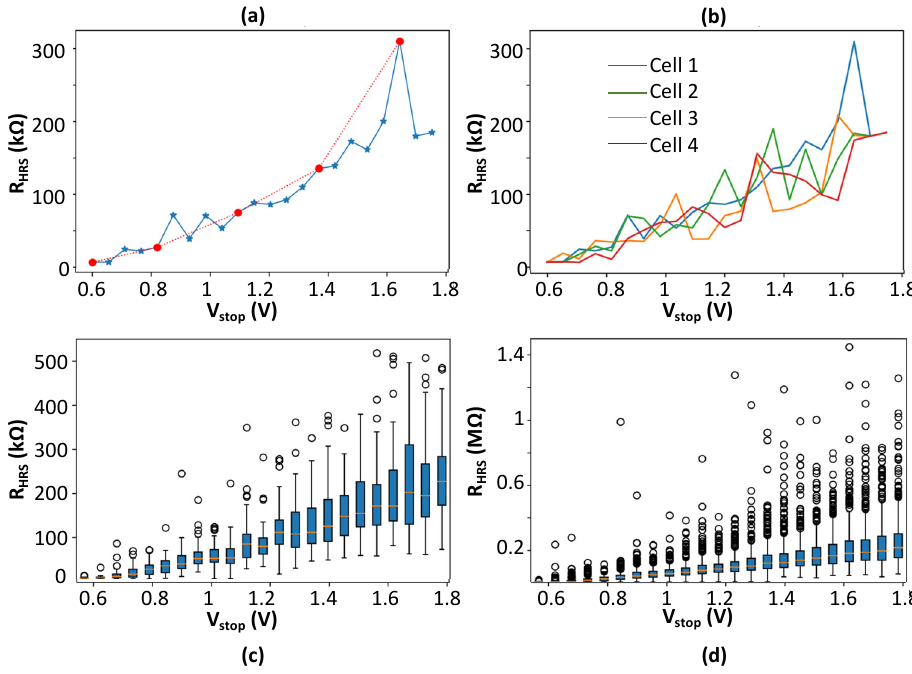
Figure 9. ( a ) R HRS vs. V stop steps for an isolated cell (center of the array). ( b ) R HRS vs. V stop steps for 4 isolated cells. ( c ) R HRS box plots vs. V stop steps. Each box plot gathers 49 measurements (D2D). ( d ) R HRS box plots vs. V stop steps. Each box plot gathers 490 measurements (D2D and C2C). The circles represent outliers showing the strong variability.